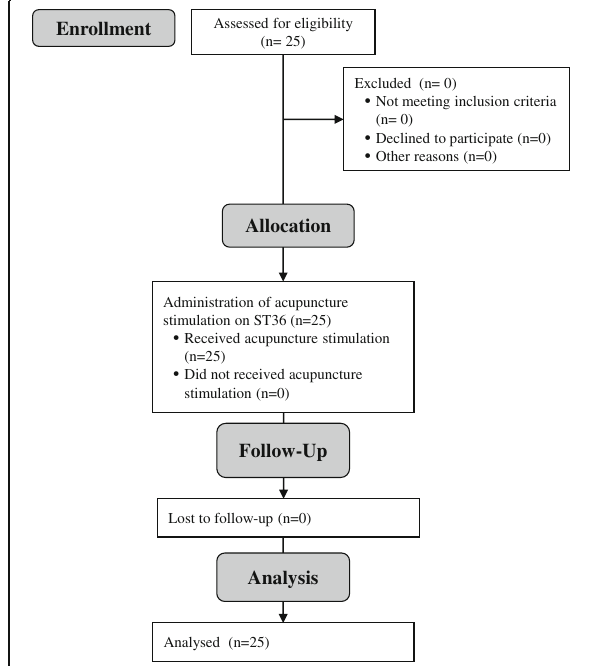
Fig. 3 CONSORT diagram for the study. Each rounded rectangle with a gray background indicates a procedure of the study, and the rectangles with a white background show the number of dropout cases and the reasons